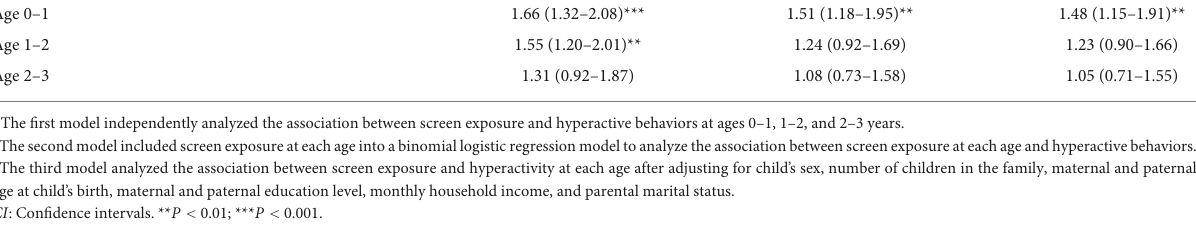
TABLE 4 Chi-square test and conditional logistic regression analysis of screen time and hyperactive